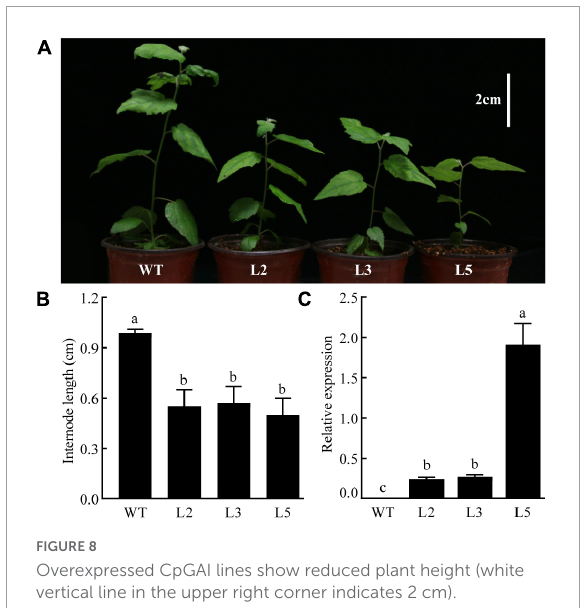
FIGURE8 Overexpressed CpGAI lines show reduced plant height (white vertical line in the upper right corner indicates 2 cm). (A) Phenotypes of transgenic lines L2, L3, and L5. (B) Internode length of transgenic lines and WT. (C) Relative expression of CpGAI in transgenic lines and WT. Different lowercase letters (a–c) above bars indicate significant differences ( p <